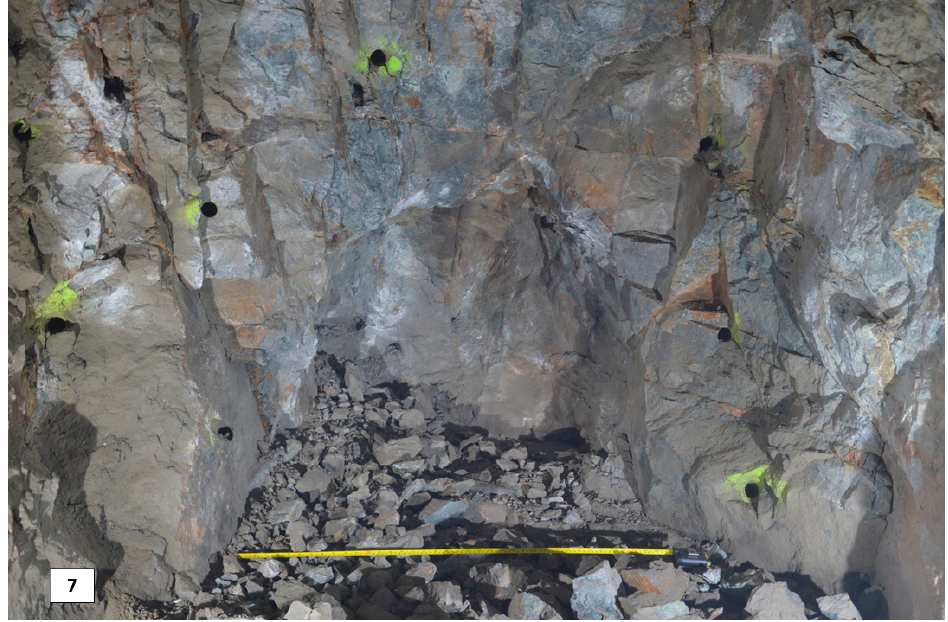
Figure A8. Cavity after detonation of hole with sequence number 7.